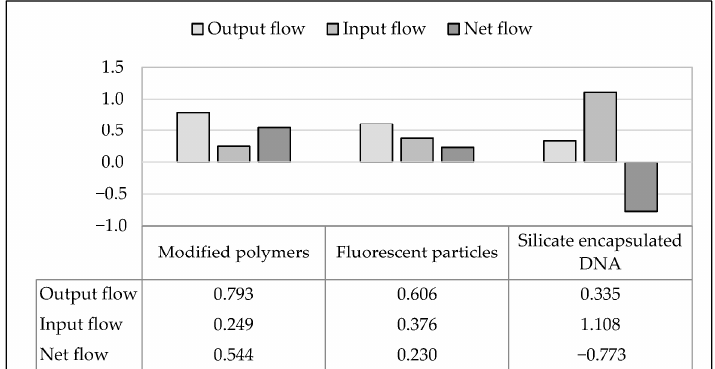
Figure 4. Presentation of results for the examined alternatives.